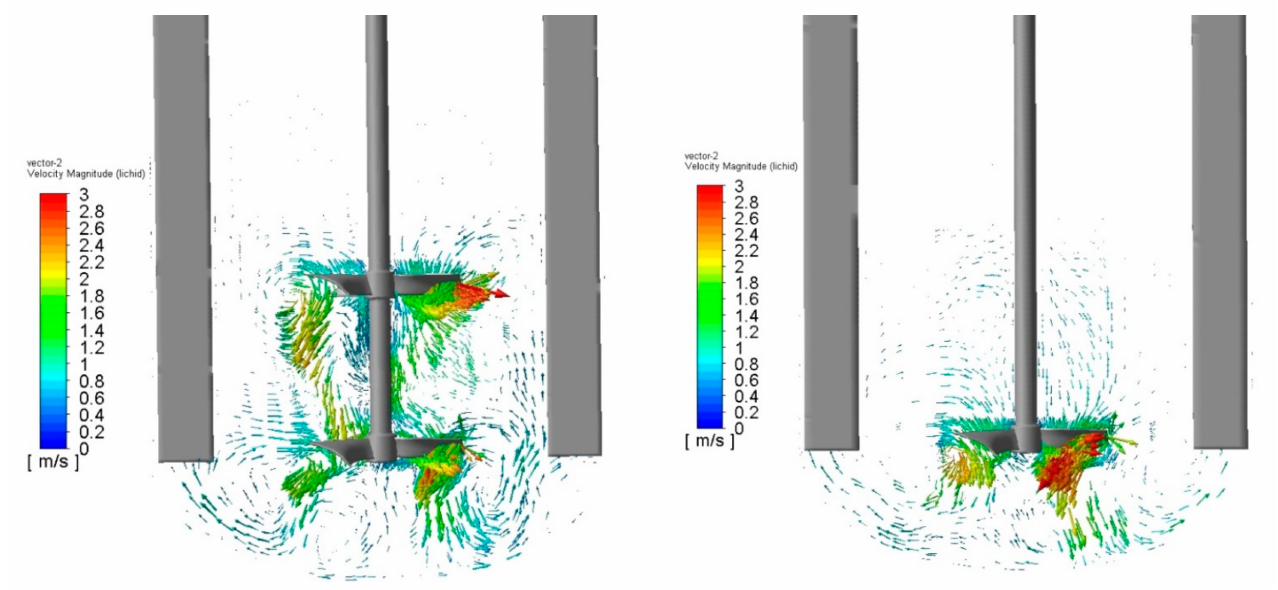
Figure 10. Distribution of the velocity vectors of the liquid phase on an axial plane, instantaneous